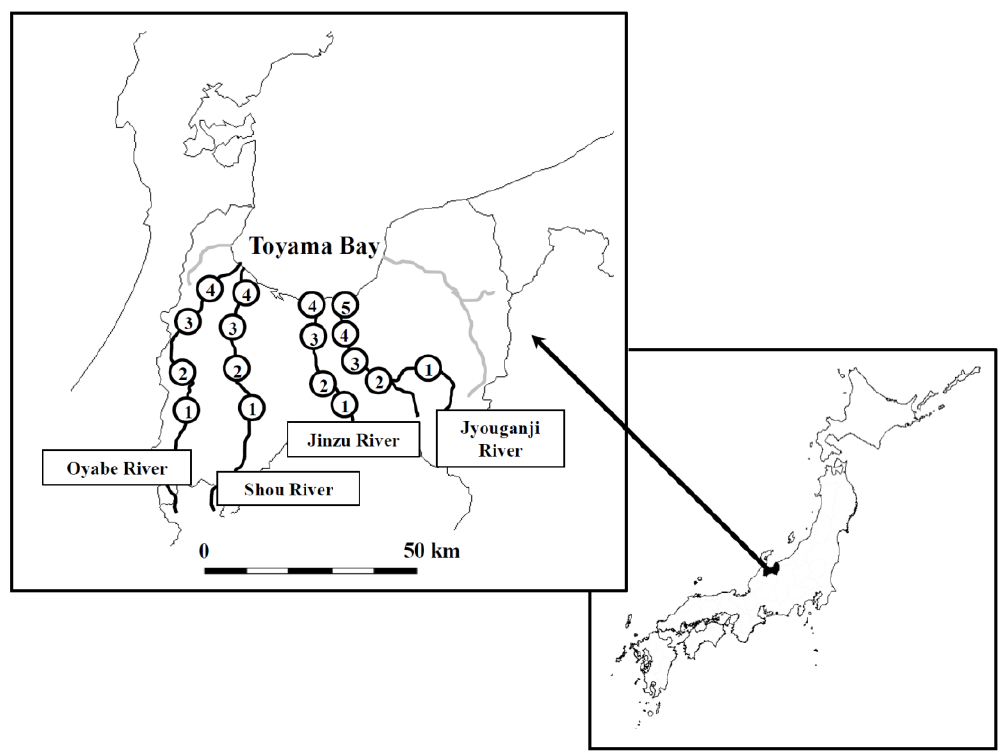
Figure 1. The location of Oyabe River, Shou River, Jinzu River, and Jyouganji River in Toyama, Japan and the sampling sites.